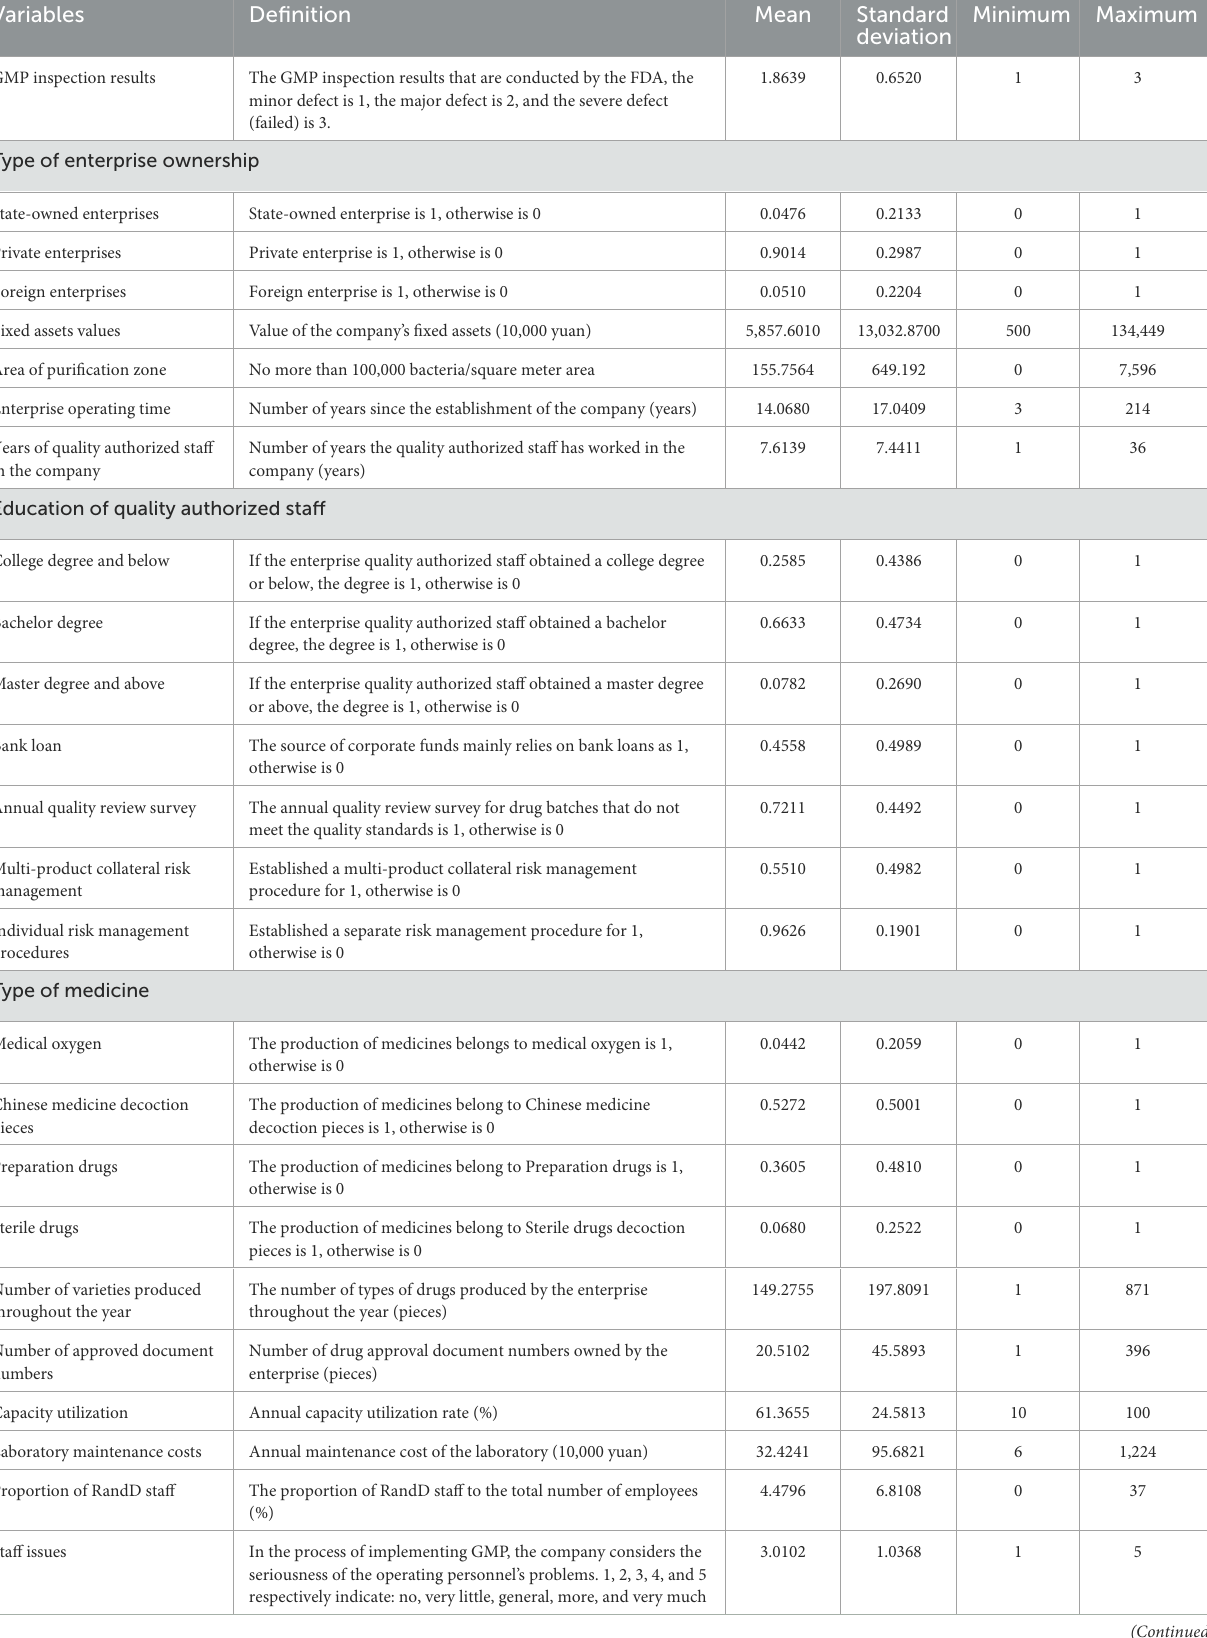
TABLE 3 The definition of variables and descriptive statistics in this